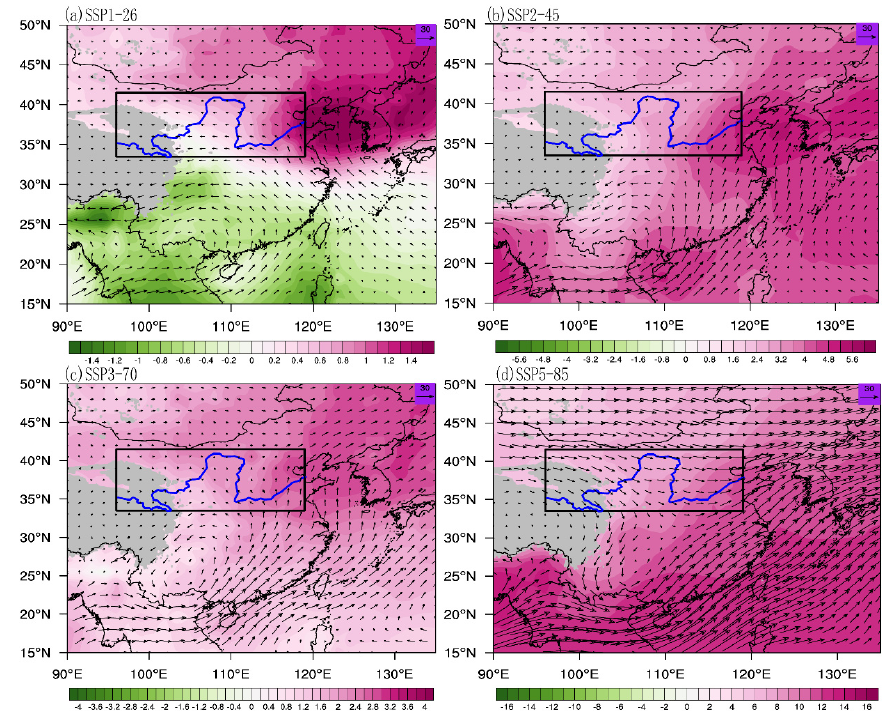
Figure 4. Future changes in the total-column specific humidity (shaded; units: kg kg − 1 ) and moisture flux (vectors; units: kg m − 1 s − 1 ) in summer projected by the selected CMIP6 models under ( a ) SSP1-2.6; ( b ) SSP2-4.5; ( c ) SSP3-7.0; and ( d ) SSP5-8.5 during the latter half period of the 21st century, relative to the historical mean. The blue line indicates the Yellow River. The black box denotes the YRB. Grey shading denotes the TP.